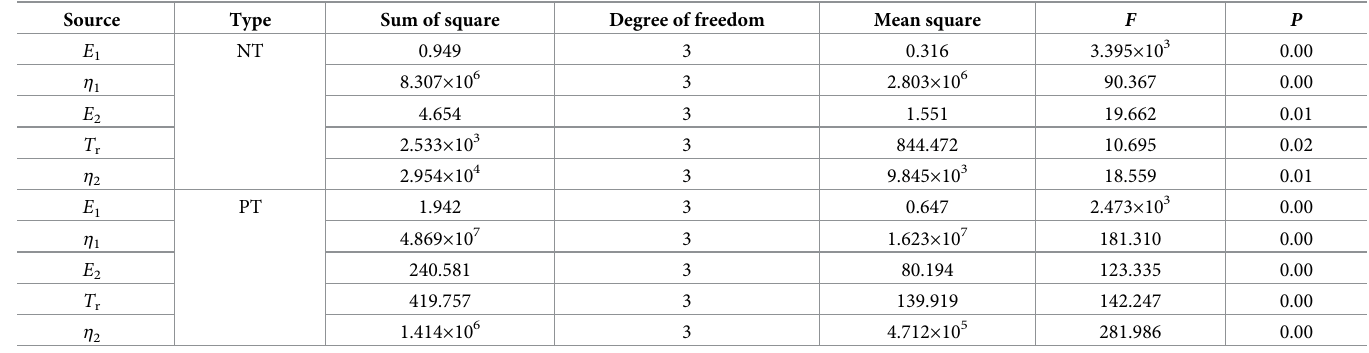
Table 3. Paddy soil variance